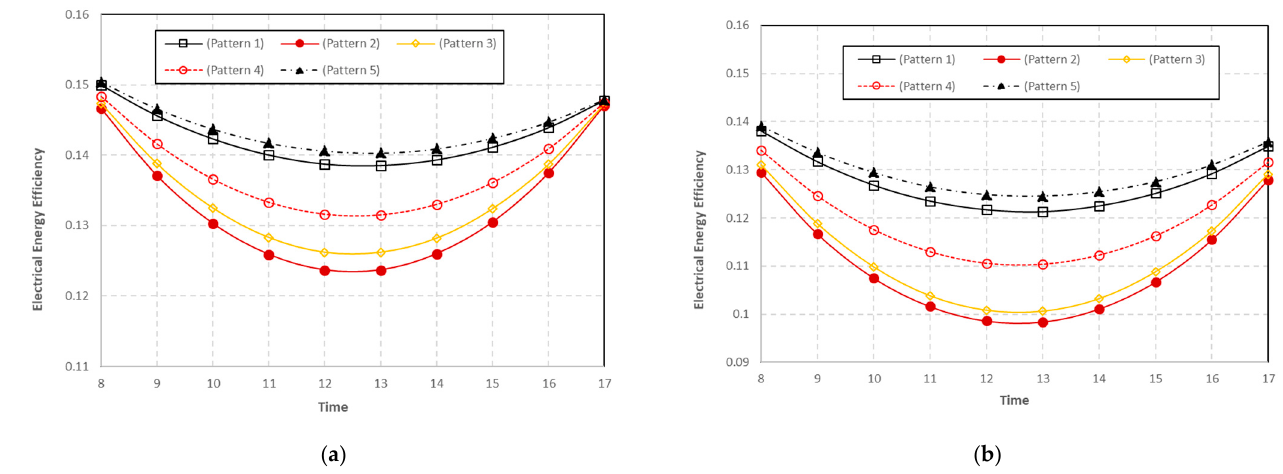
Figure 16. Hourly variations in efficiency of electrical exergy for different configurations ( a ) during Winter day ( b ) during Summer day.